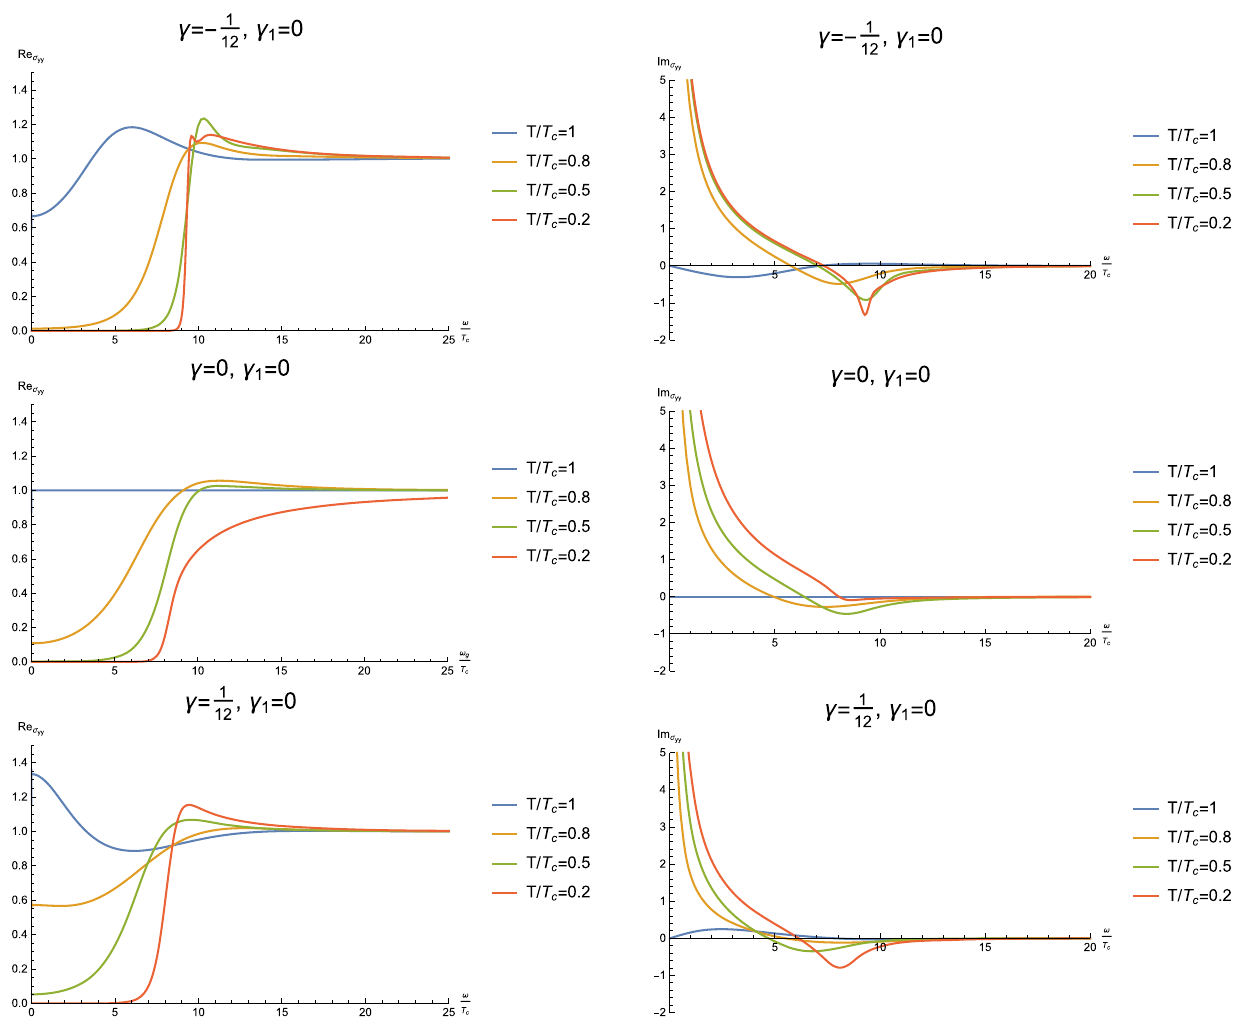
Fig. 2 Real and imaginary parts of AC conductivity σ yy in 4 derivative